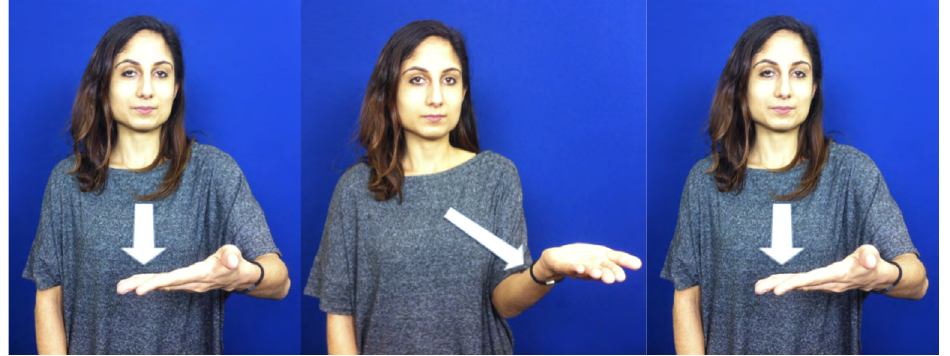
Figure 7. Unmodified, modified and congruent forms of BSL indicating verb give